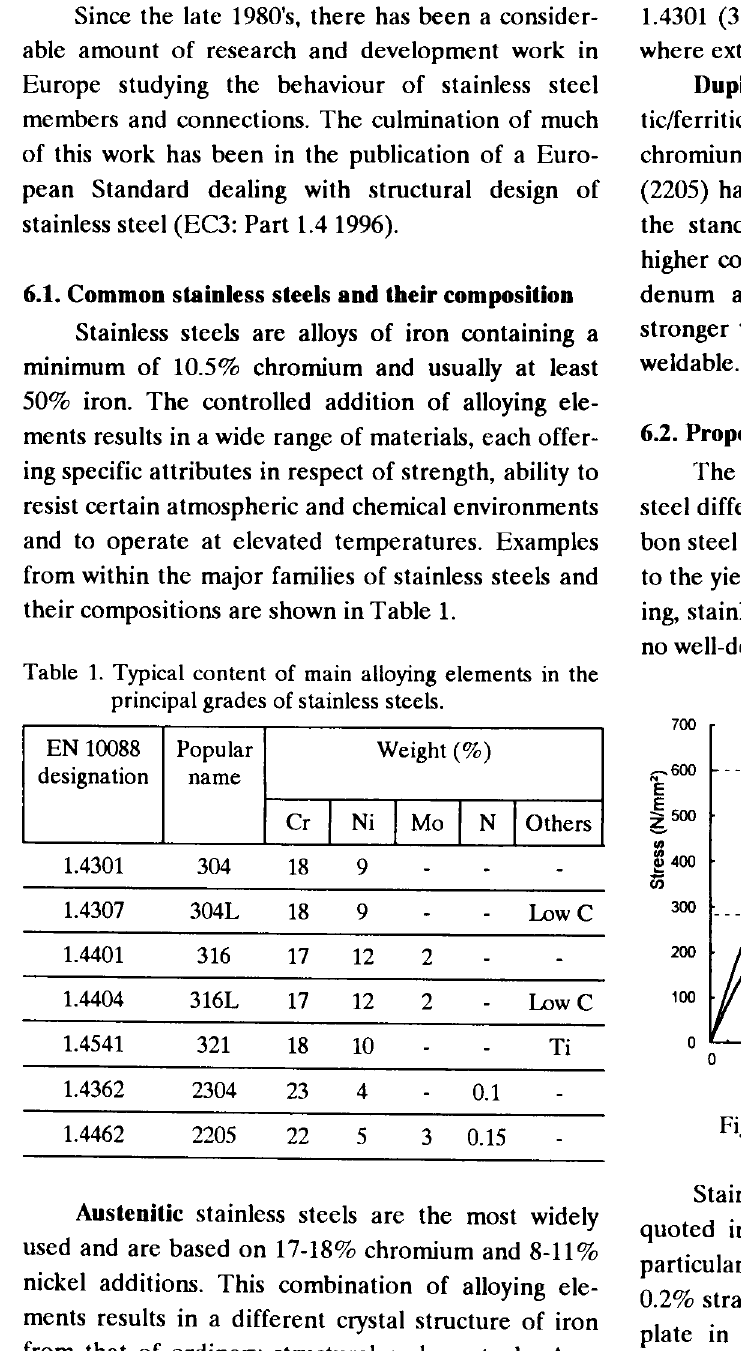
Table 1. Typical content of main alloying elements in the principal grades of stainless steels.